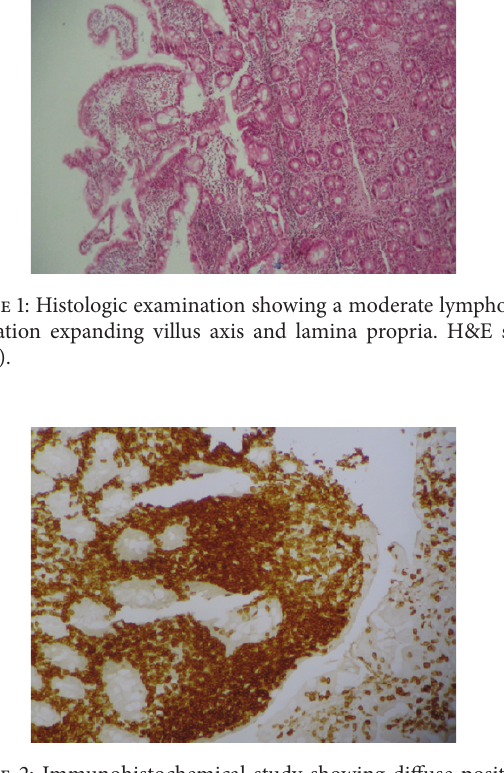
Figure 2: Immunohistochemical study showing diffuse positivity for CD 30 ( ×